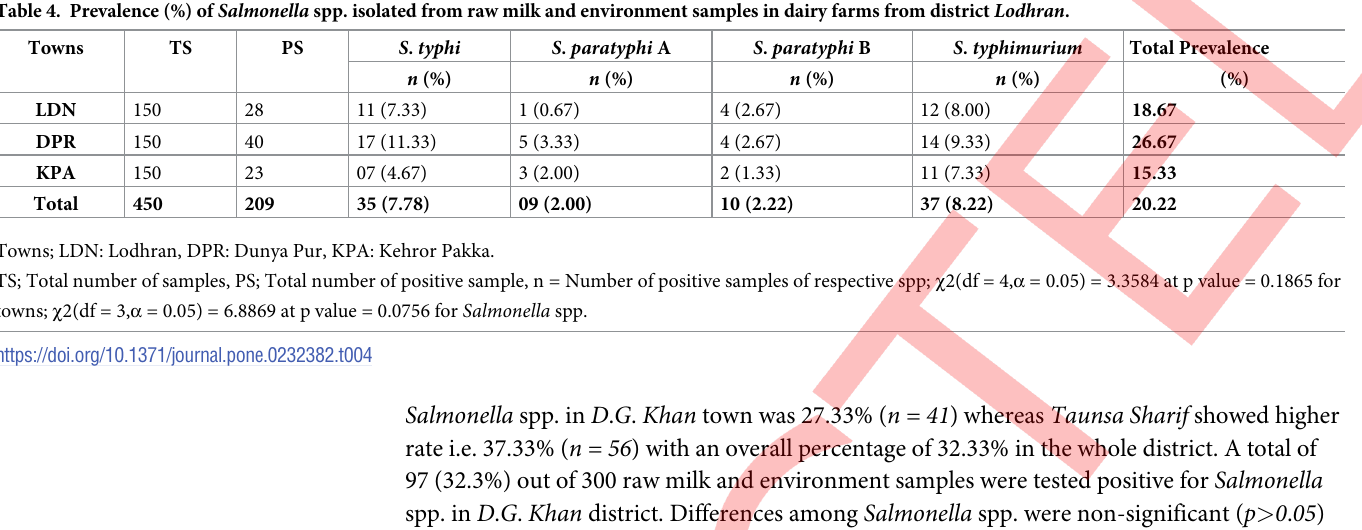
with regard to prevalence in towns of D . G . Khan district as shown in Table 5.